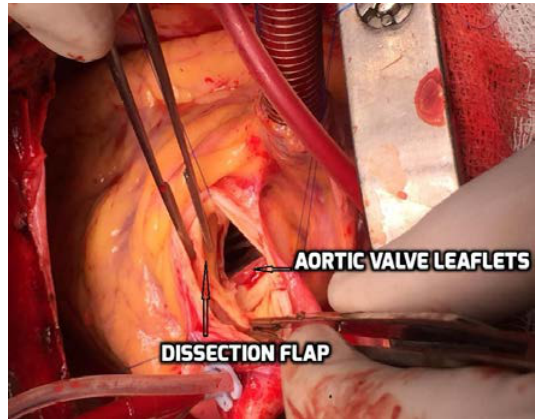
Figure 2. Repair of the aortic dissection